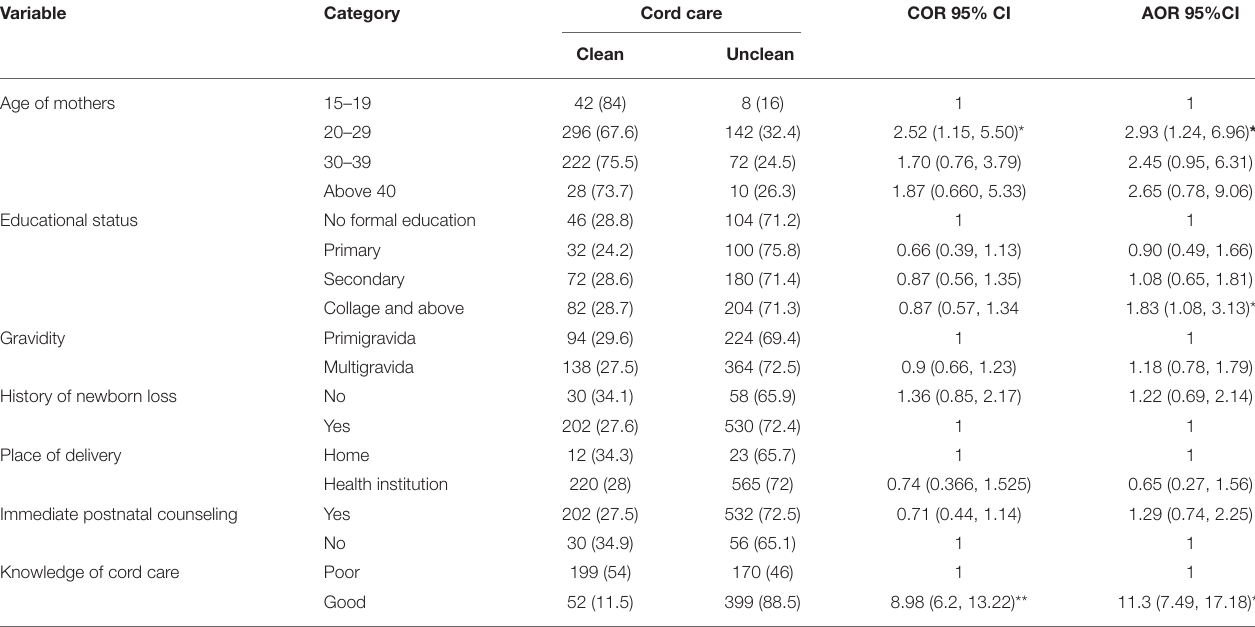
TABLE 4 | Determinants of cord care practice among post-partum women at public hospitals in eastern Ethiopia, 2021.